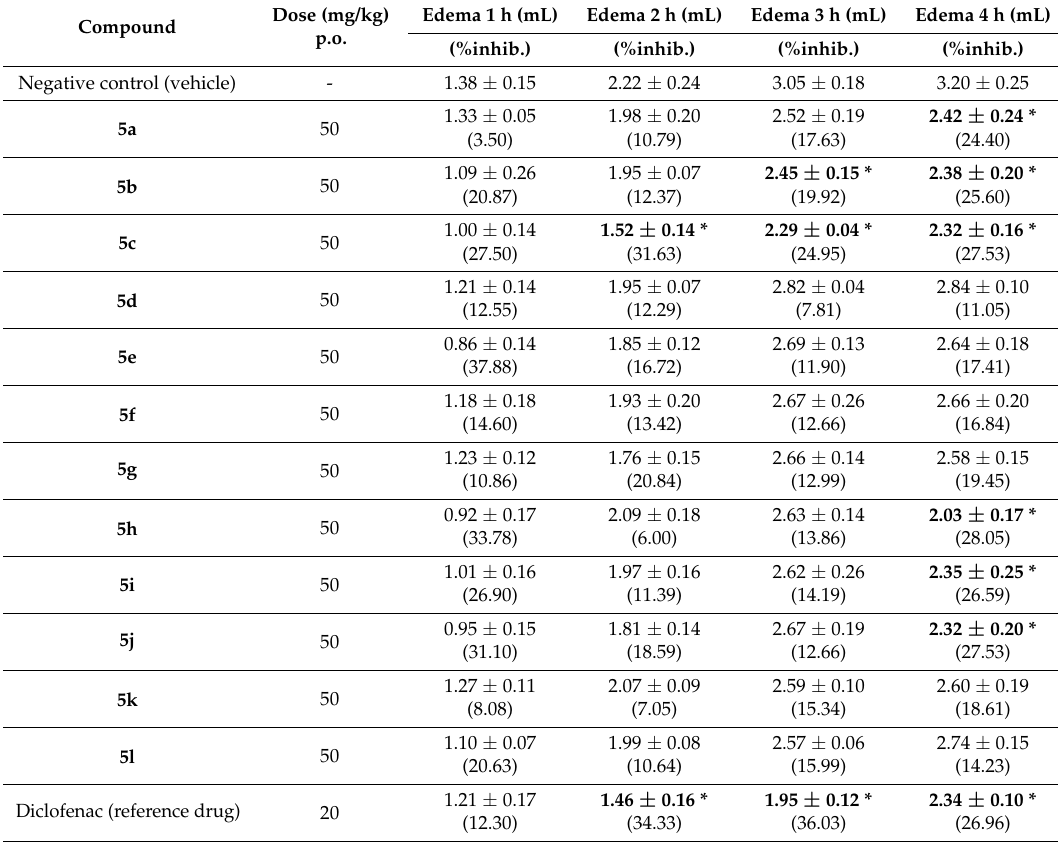
Table 1. In vivo anti-inflammatory activity of synthesized compounds on carrageenan-induced paw edema in rats. Dose (mg/kg) Compound p.o. (%inhib.) (%inhib.) (%inhib.)